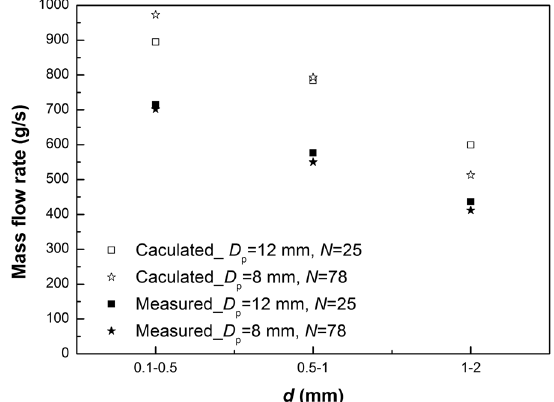
Figure 6. Comparison of measured mass flow rate through equivalent multiple pipes and the ones calculated from Beverloo’s